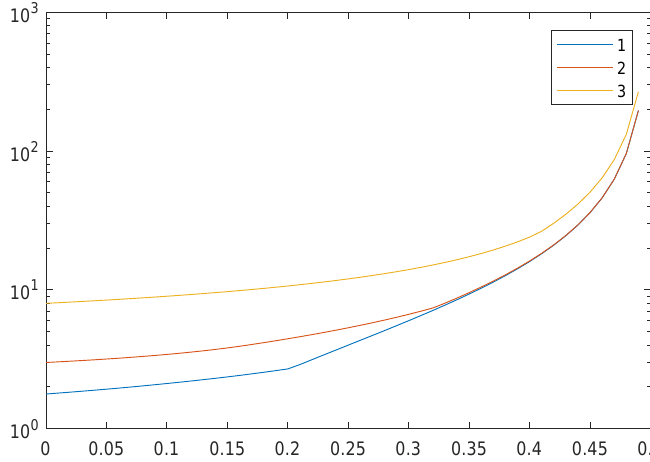
Figure 1. Maxima of eigenvalue surfaces of the symbol f Q